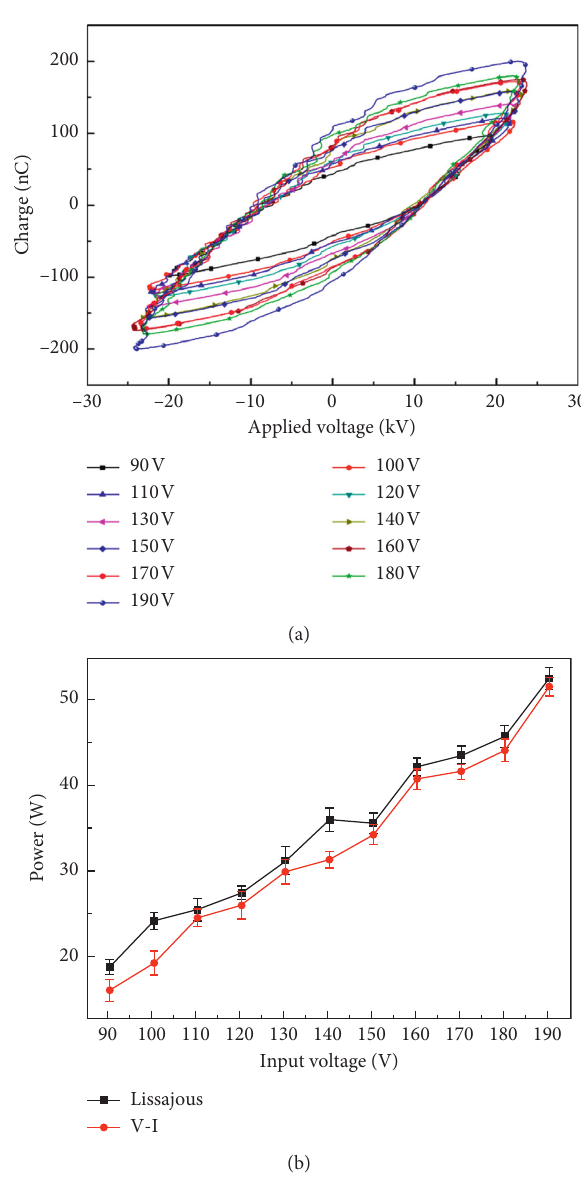
Figure 7: (a) Lissajous figures of the DBD-PACA under different input voltage and (b) the trend of power calculated by Lissajous figure and current-voltage methods with input voltage.